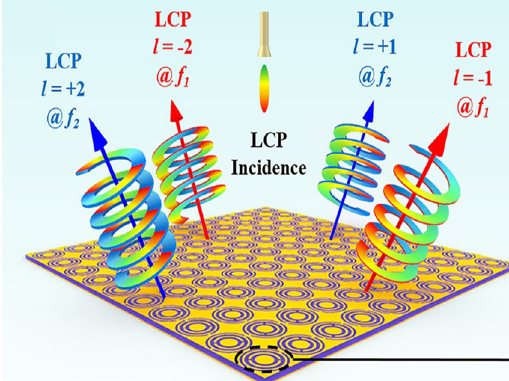
Figure 19: Independent phase controls at two frequencies [110]. Reprinted from [110], with the permission of AIP